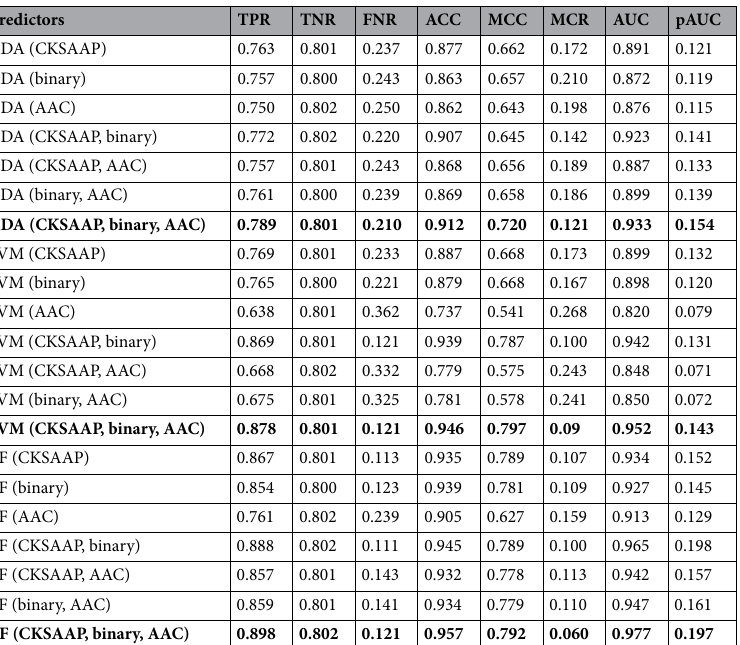
Table 1. Training performance scores at FPR = 0.20 for 21 prediction models that were trained by 1:2 ratio of positive and negative samples. Better results with each of ADA, SVM and RF were highlighted by bold